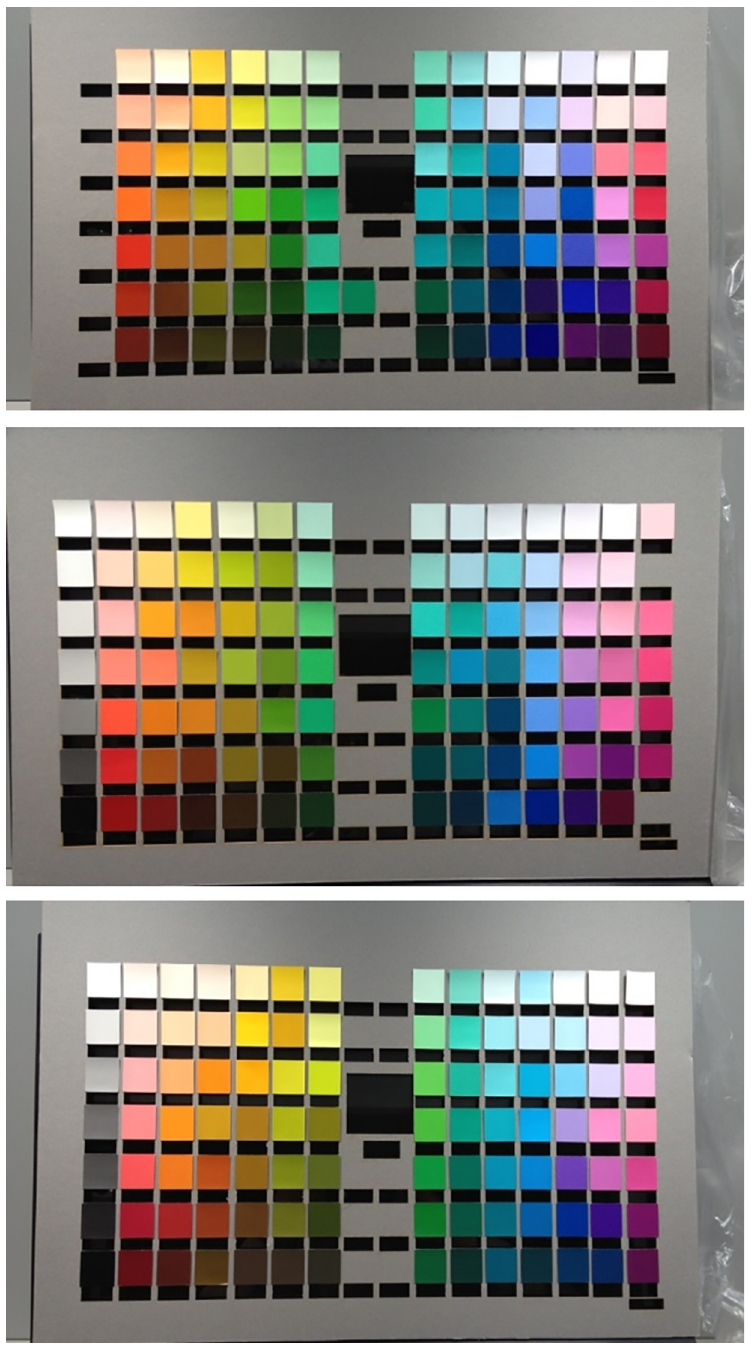
Fig 2. The color samples presented during the survey: color chips mounted on